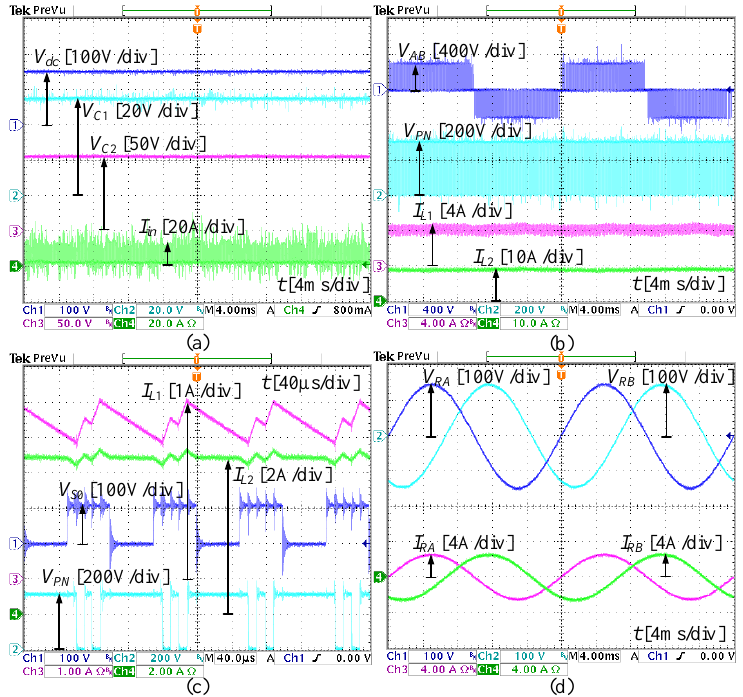
Figure 10. Experimental results for 150 V input voltage. From top to bottom: ( a ) input voltage V dc , capacitor voltages V C 1 , V C 2 , input current I in , ( b ) output line-to-line voltage V AB , DC-link voltage V PN , inductor currents I L 1 , I L 2 , ( c ) inductor currents I L 1 , I L 2 , switch S 0 voltage V S 0 , DC-link voltage